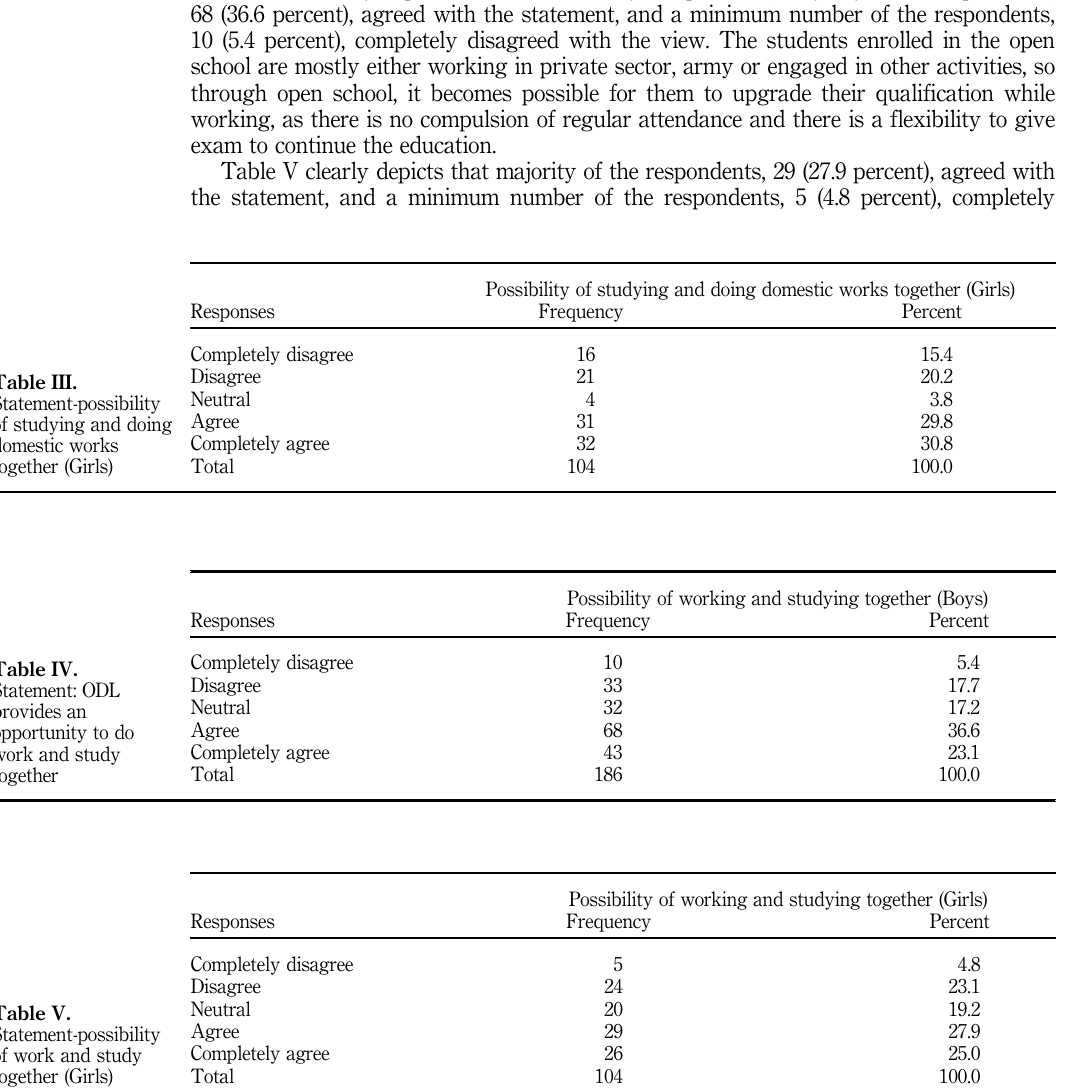
of work and study together